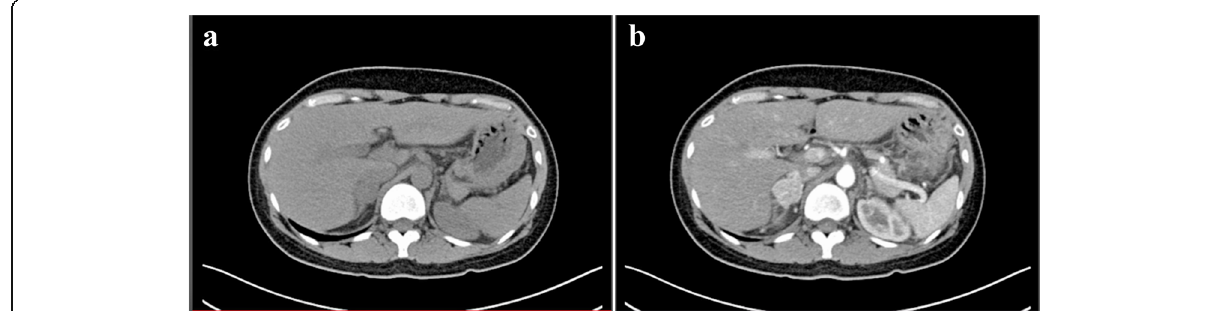
Fig. 1 Computed tomography image showing a circular soft tissue density shadow in the right adrenal gland of the patient ( a ). The lesion in the arterial phase is markedly heterogeneous with a clear boundary after enhancement ( b )